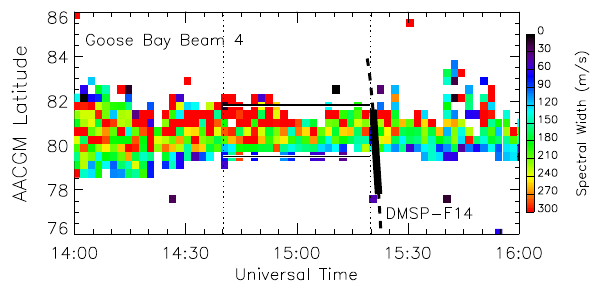
Fig. 6. The variation of spectral width with AACGM latitude and universal time as observed by beam 4 of the Goose Bay Super- DARN radar during the interval 14:00–16:00 UT on 11 Novem- ber 1998. The vertical dotted lines delineate the sub-interval of data studied in detail in this paper. The horizontal lines delineate the average latitudinal range of the backscatter during this interval. The dashed black line marks the track of the DMSP-F14 spacecraft. The thick black line marks the region of significant ion precipitation (cusp and LLBL) as shown in Fig. 5.